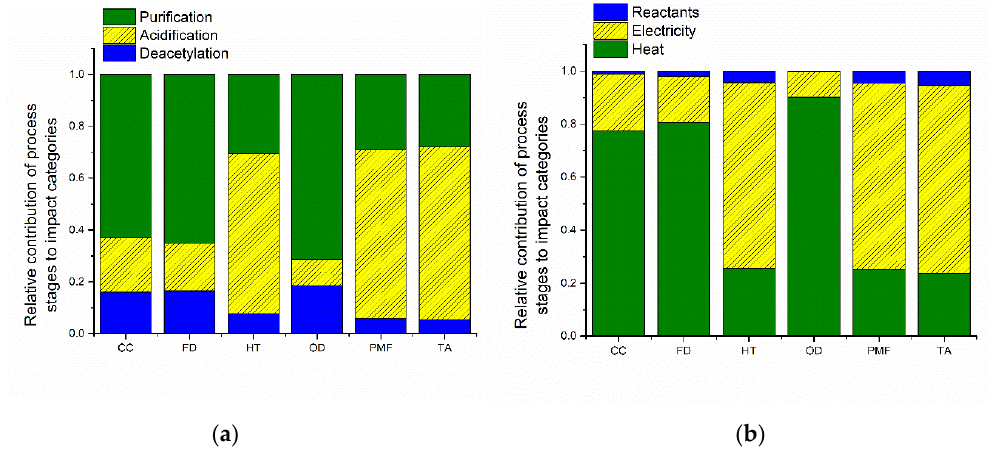
Figure 7. The relative contribution of process stages and inputs to the evaluated impact categories in LCA results obtained for the pretreatment stage in glucose production from woody biomass residues. ( a ) Impact aggregation by sub-process; ( b ) impact aggregation by input.